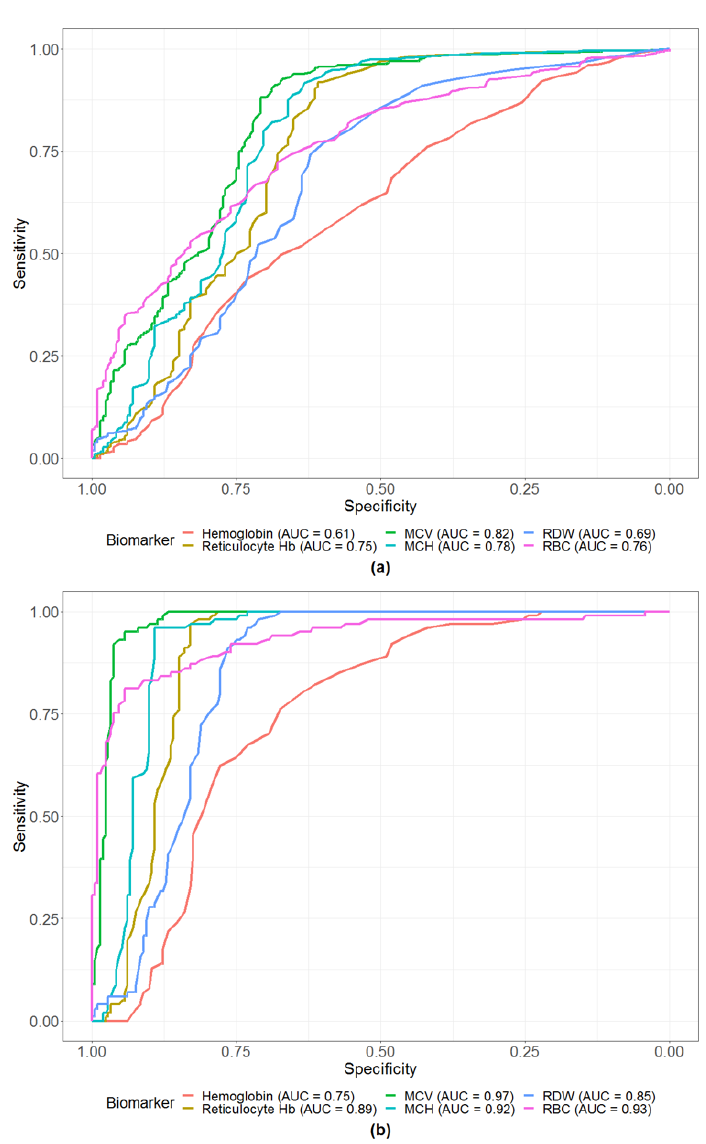
Figure 1. ( a ) Receiver operating characteristic (ROC) curves for the individual CBC biomarkers in the prediction of any genetic hemoglobinopathy. ( b ) Receiver operating characteristic (ROC) curves for the individual CBC biomarkers in the prediction of the homozygous EE disorder. AUC, area under the curve; Hb, hemoglobin; MCV, mean corpuscular volume; MCH, mean corpuscular hemoglobin; RDW, red blood cell distribution width; RBC, red blood cell.